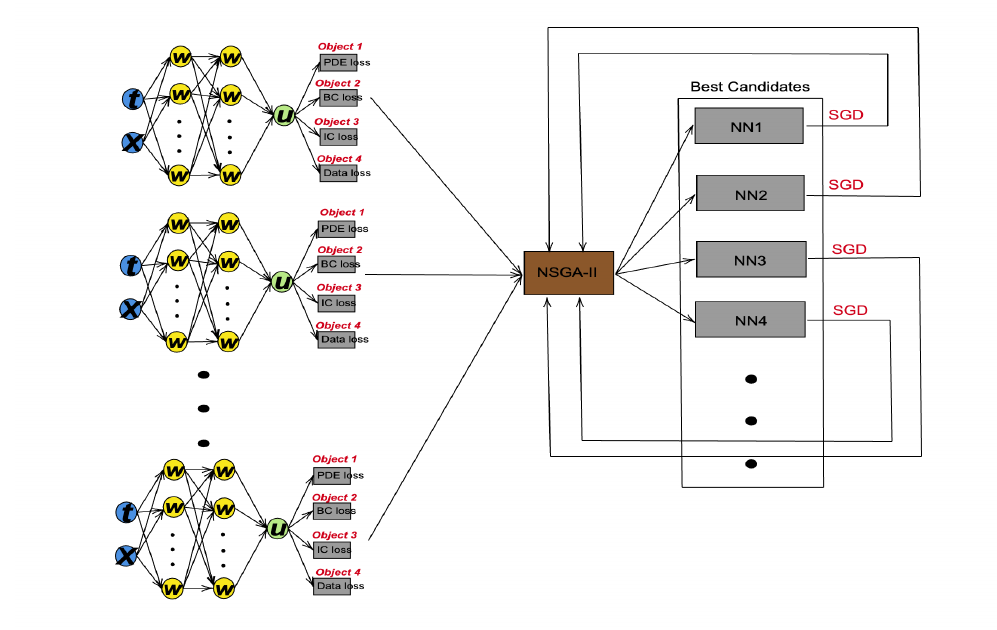
Figure 2. NSGA-PINN structure